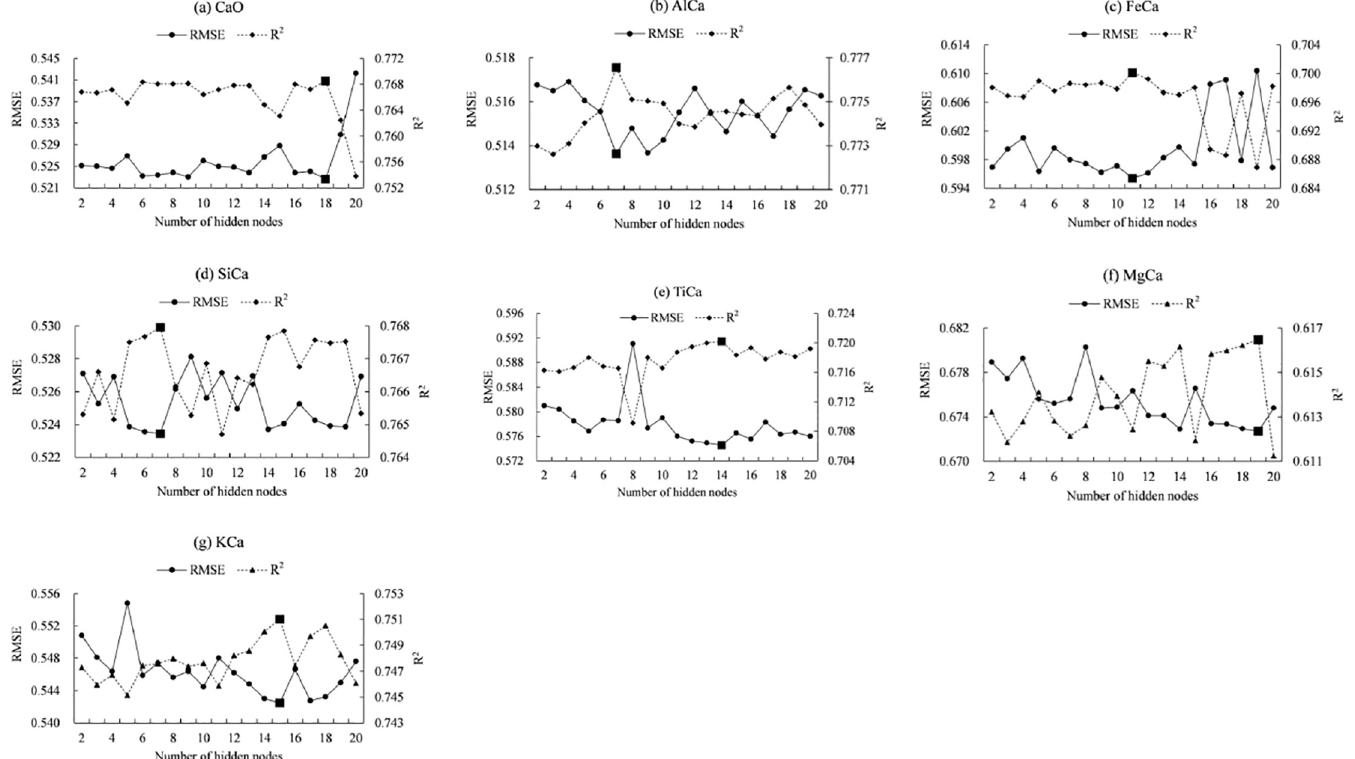
Fig 4. Relationships between soil pH and the geochemical